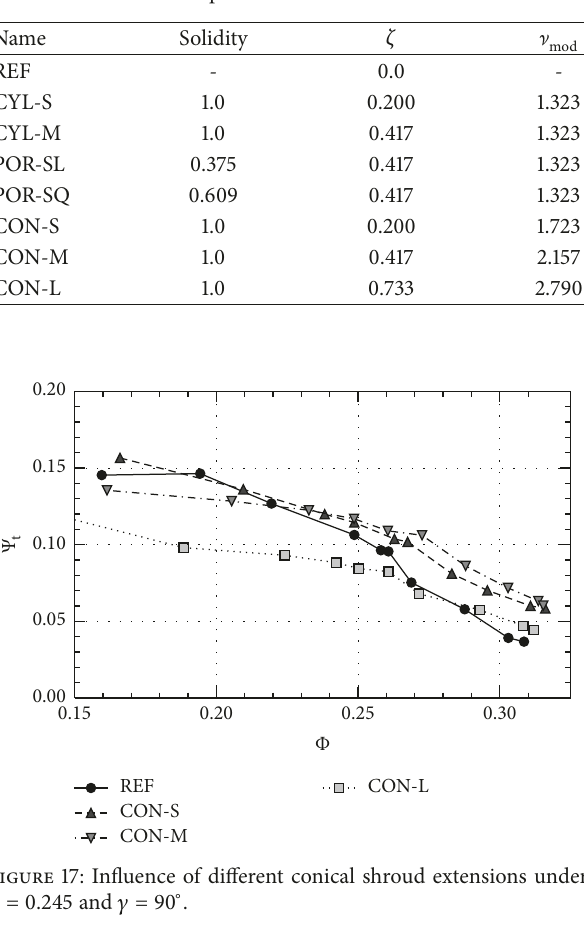
Table 2: Geometric parameters of inlet shroud extensions.